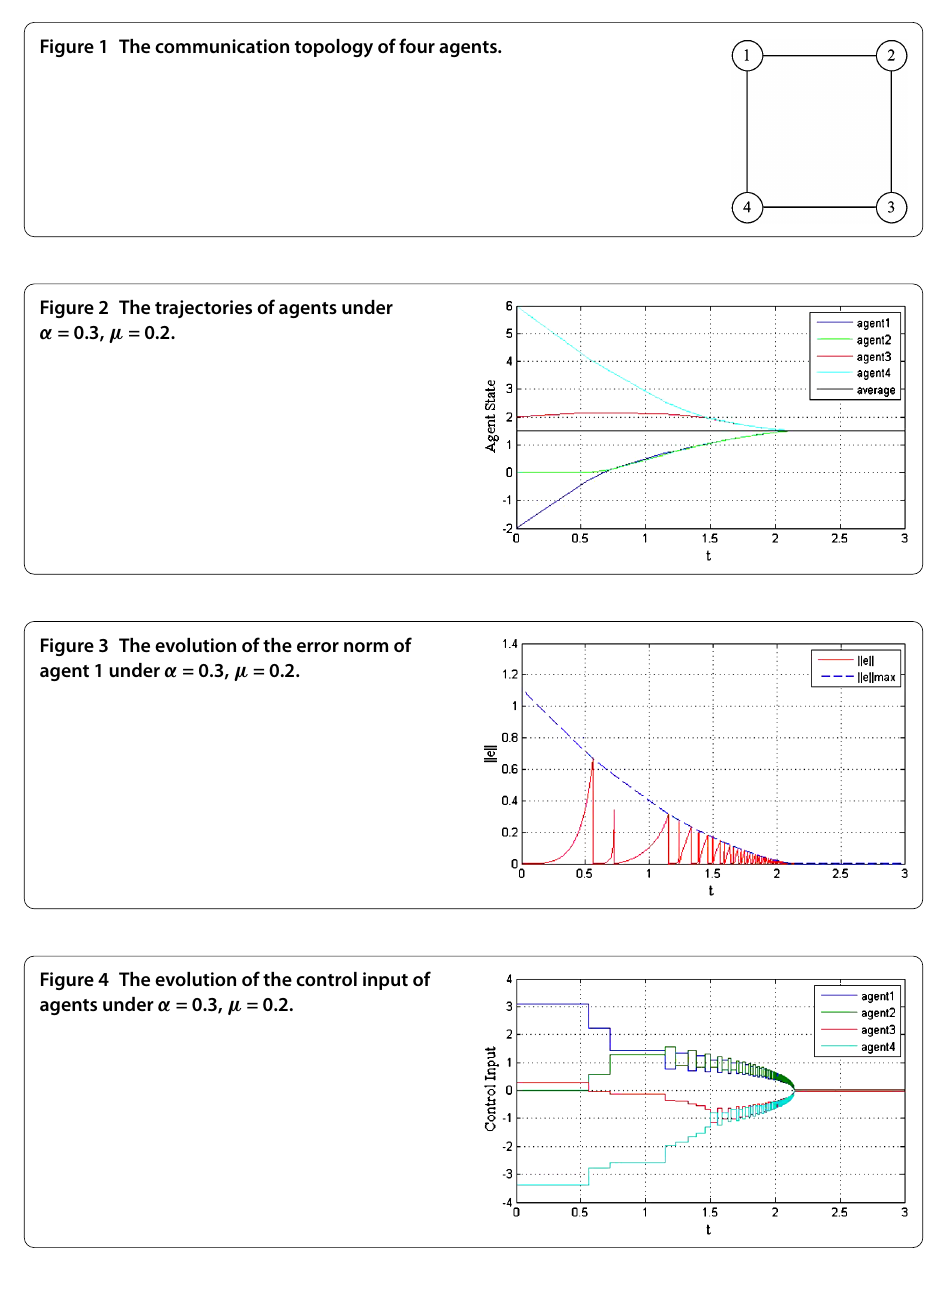
Figure 1 The communication topology of four agents.